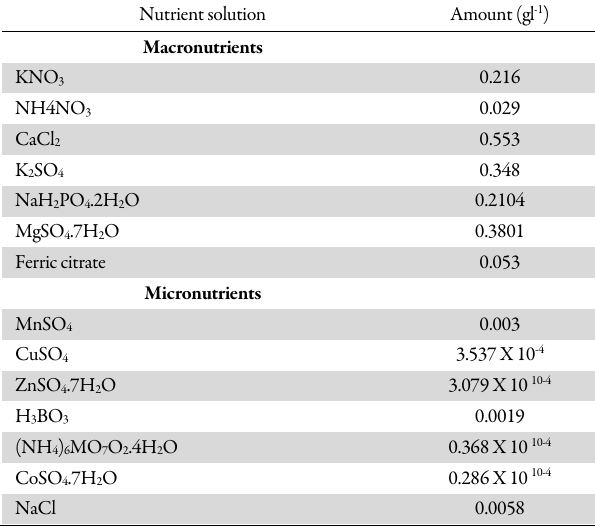
Table 1. The composition of nutrient